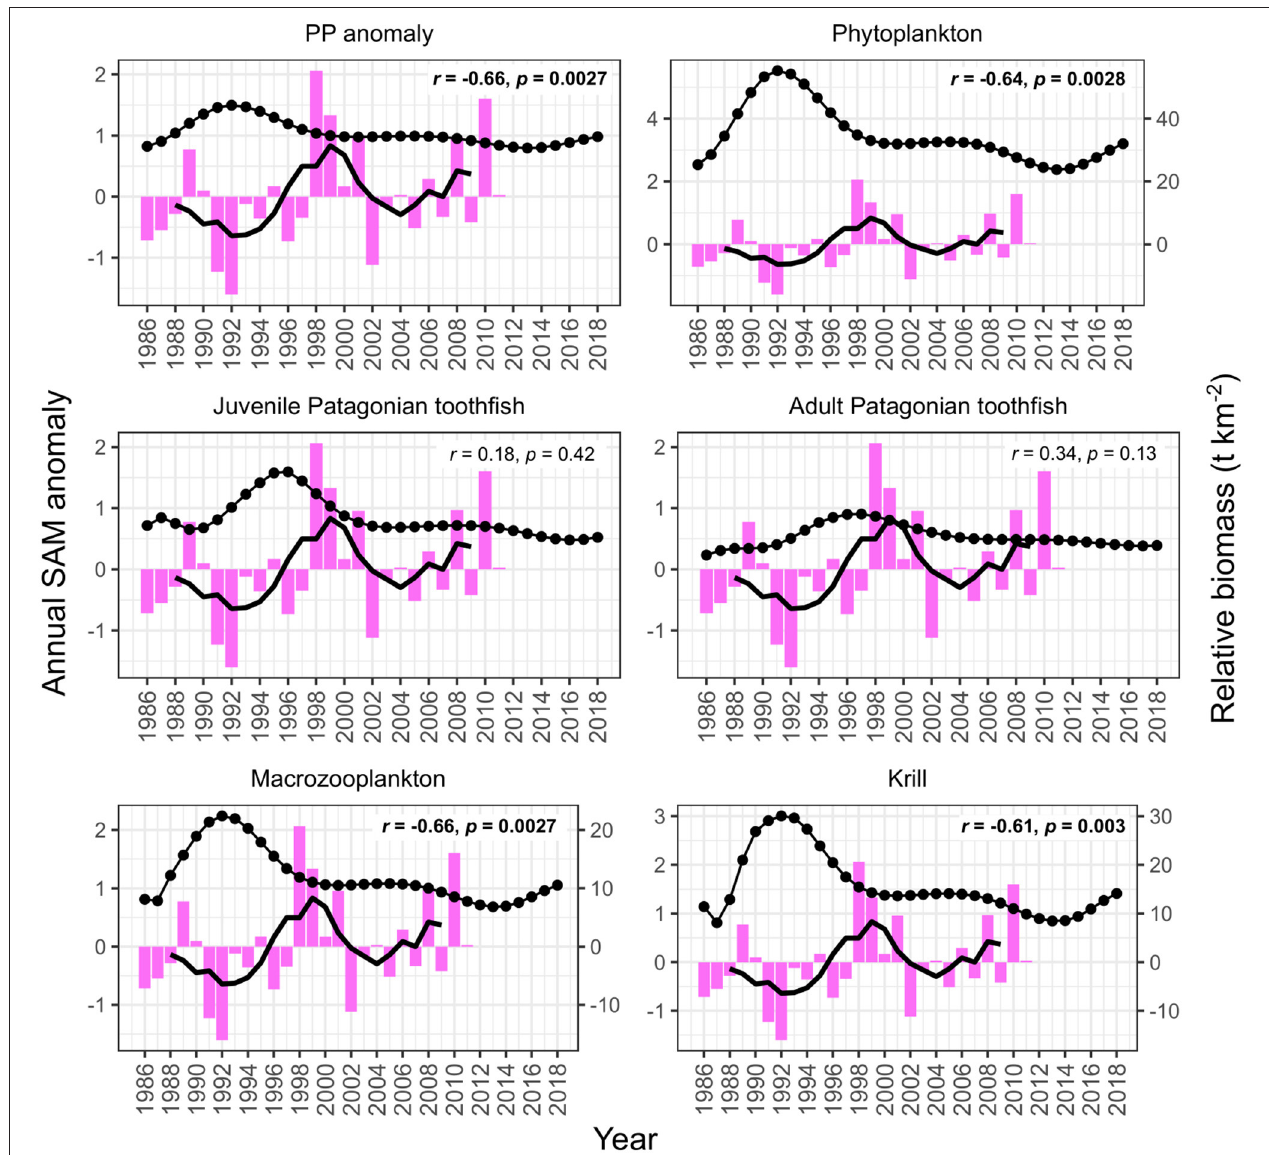
FIGURE 8 | Model output correlations to the Southern Annular Mode (SAM) (pink bars). Black points are the estimated annual biomass values for each year of the model period and black line indicates moving average used to perform correlations (relative biomass in t km − 2 , right axis for phytoplankton, macrozooplankton, and krill). Strength of correlations are shown by the r and p values in each plot, with significant correlations in